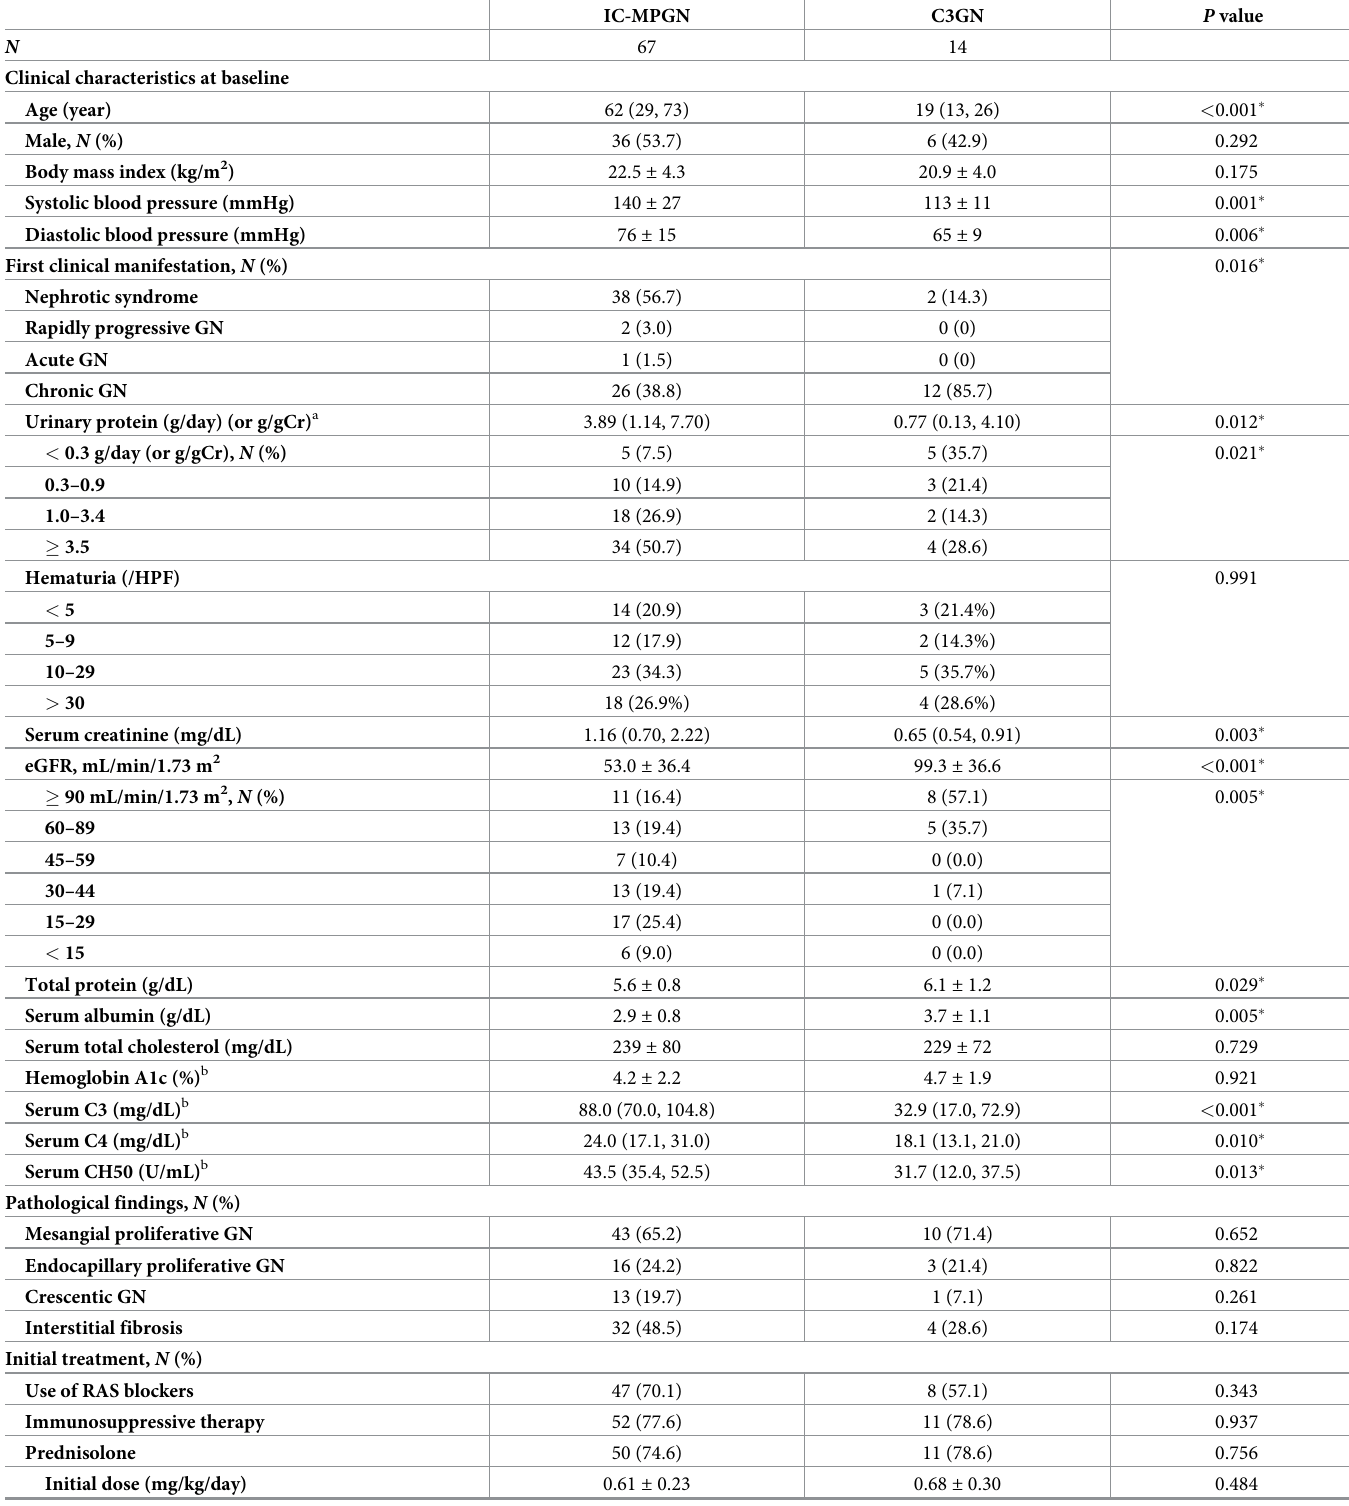
Table 1. Clinicopathological findings at baseline and initial treatment between IC-MPGN and